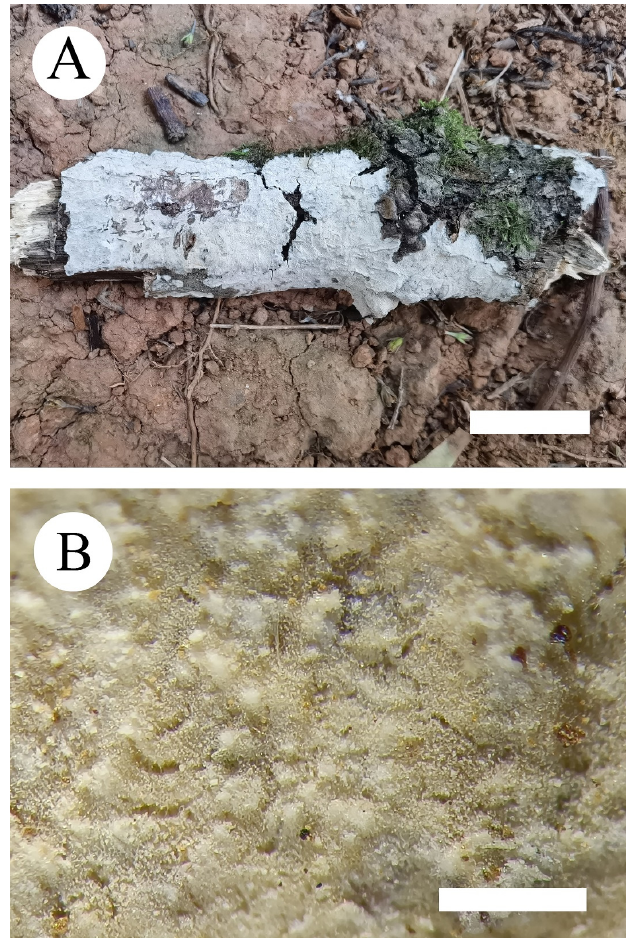
Figure 3. Basidiomata of Phanerochaete pruinosa (holotype) Bars: ( A ) = 2 cm and ( B ) = 1 mm. Etymology— pruinosa (Lat.): from Latin , referring to the white powder on hymenial surface of basidiomata. Fruiting body— Basidiomata annual, resupinate, adnate, undetachable from sub- strate, membranaceous to coriaceous, without odor and taste when fresh, up to 15 cm